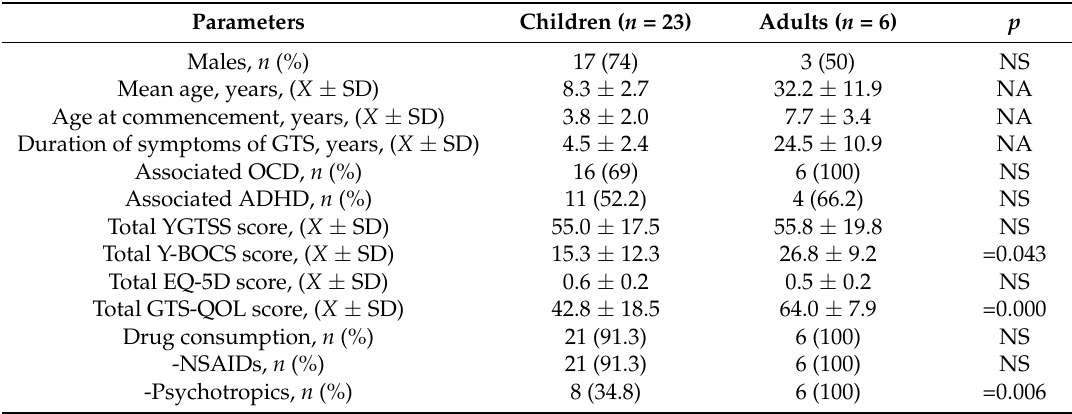
Table 1. Baseline demographic characteristics of children and